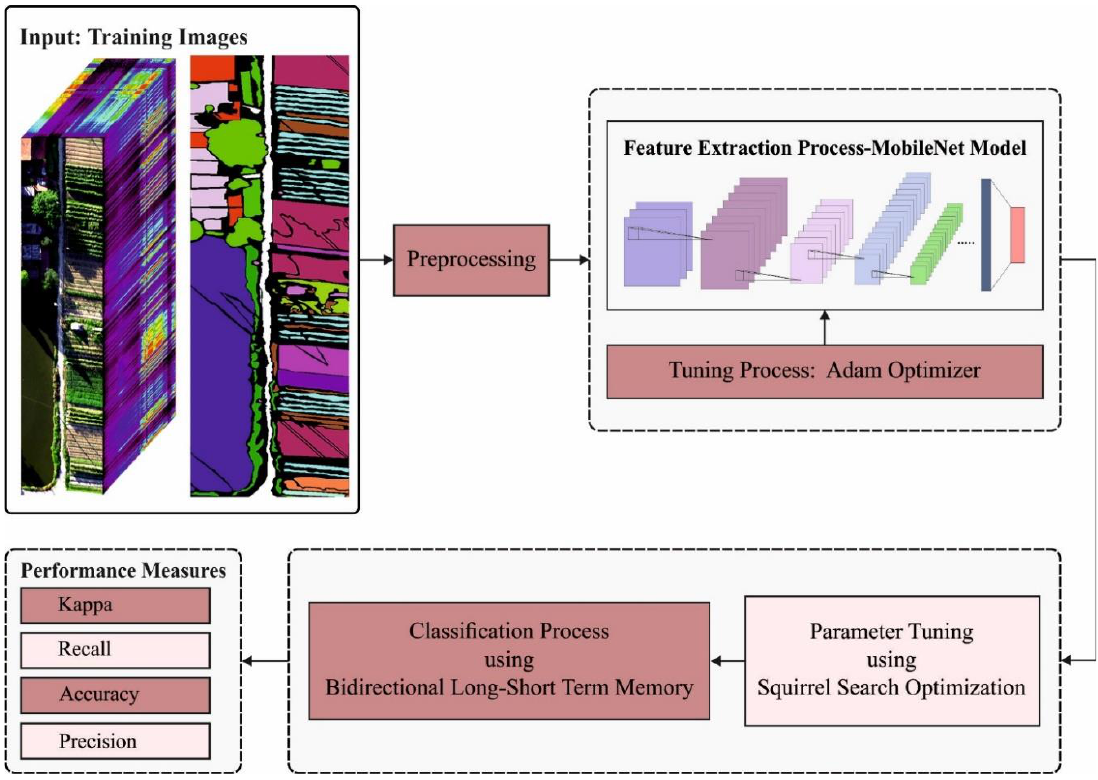
Figure 1. Block diagram of the SSODTL-CC technique.